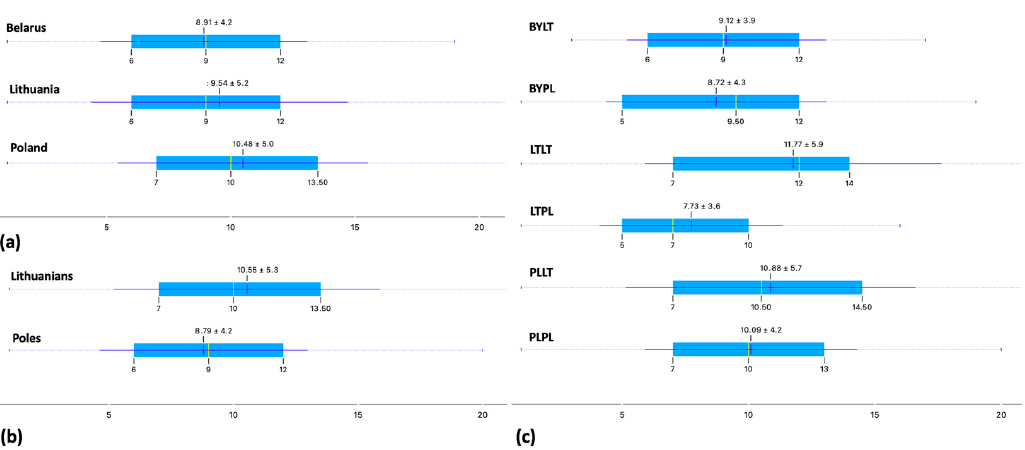
Figure 5. Box plots for the ‘number of taxa mentioned’ grouped by ( a ) country, ( b ) ethnic group, and ( c ) case study.